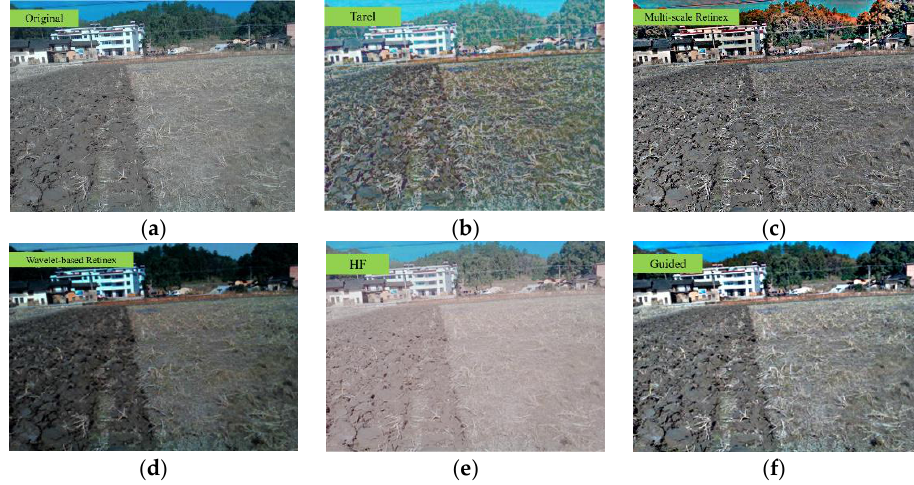
Figure 12. The input image and experiment results of the filtering algorithms: ( a ) original; ( b ) Tarel; ( c ) multi-scale retinex; ( d ) wavelet-based retinex; ( e ) HF; ( f ) guided.